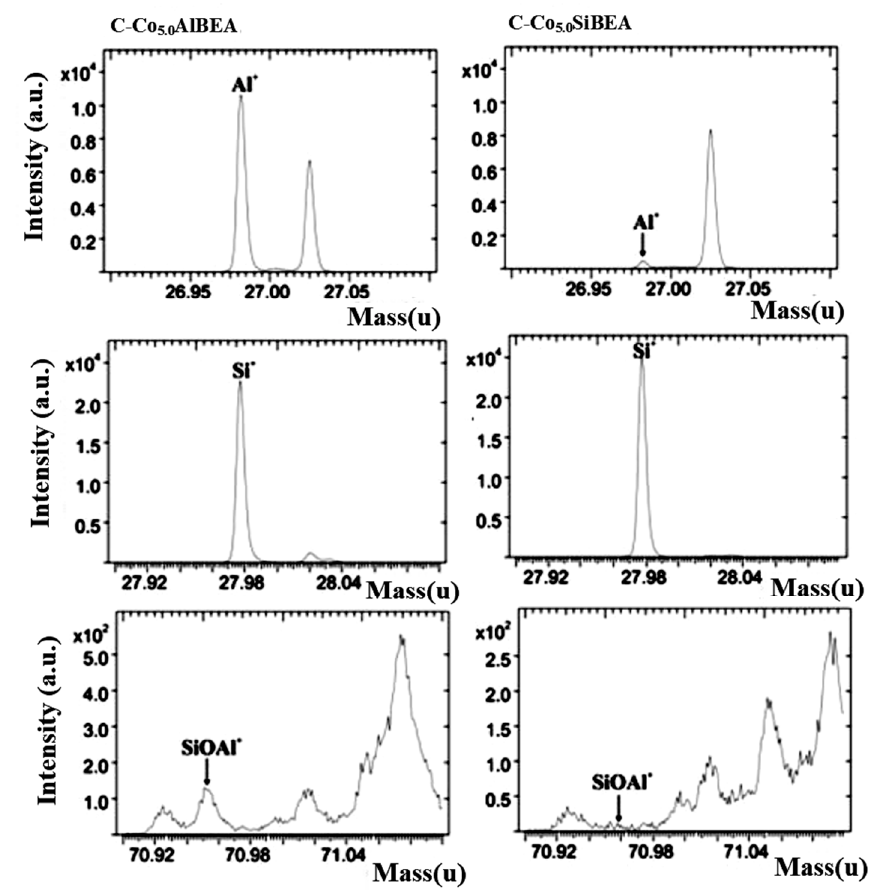
Catalysts 2020 , 10 , x FOR PEER REVIEW Figure 3. ToF-SIMS spectra of Al + , Si + and SiOAl + ions collected for C-Co 5.0 AlBEA and C-Co 5.0 SiBEA. obtaining.